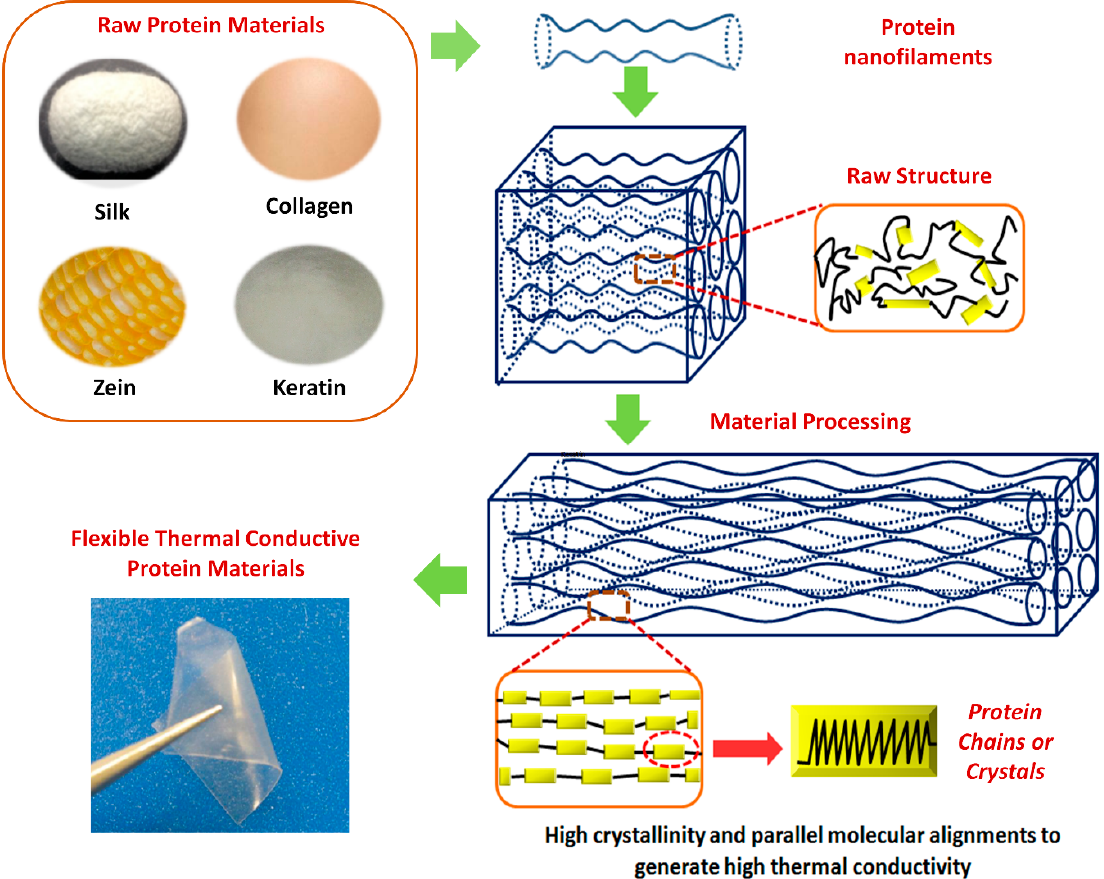
Figure 2. Illustration of the relations between raw protein materials, material processing and flexible thermal conductive protein materials. Tunable thermal conductivity can be achieved through modifying the structure of protein structures.